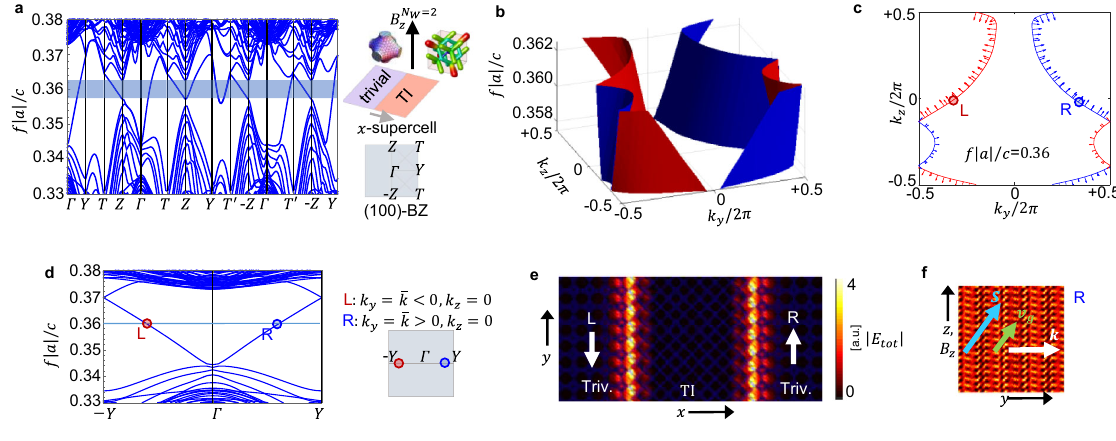
Fig. 4 3D CI surface states. Projected band-structure on the surface BZ with Miller index (100), for the interface between N triv = 8 cells of trivial insulator and N TI = 8 cells of TI, under a B ¼ B z ^ z fi eld and with unit Chern number. Edge states cross the topological gap, highlighted in the shaded region. The extended BZ is fully displayed from − Z to Z , since it lacks of TRS due to application of a ^ z directed bias fi eld. b 2D dispersion of topological surface states on the projected BZ, in the energy range of the topological band-gap. c Equifrequency loops for a cut taken at midgap: the arrows on the plot indicate the direction of the group velocity v g = ∇ k f ∣ a ∣ / c = ( v y , v z ). Blue and red colors correspond to chiral partners with opposite v y and same optical chirality (cid:1) c which are located on opposite left/right sides of the interface ( L , R ). d Edge states dispersion along a direction normal to both the interface and the external magnetic fi eld; highlighted in circles is a pair of counterpropagating m − th edge channels with ± k y : the spatial pro fi le of their total electric fi eld is shown in two following panels. e Counterpropagating chiral partners located on the two opposite left/right surfaces of the sample ( L , R ): wavefront propagation in the k direction indicated by White arrows on a xy cross section. f Spatial pro fi le of the total electric fi eld on a yz planar cut: green and blue arrows indicate respectively the group velocity v g and the total Poynting vector S , the last being obtained from a spatial integral of the quantity Re ( E × H * ), calculated directly from the EM fi eld pro fi les. Differently from what expected from a conventional QHE edge channel, the Poynting vector displays a component parallel to the external magnetic fi eld ( S z ≠ 0), suggesting both QHE and CME features and the possibility of energy fl ow along the magnetization axis: we excluded such a possibility in the SN 9, by summing up the contributions of all the edge channels constituting the surface state. Source data are provided as a Source Data fi